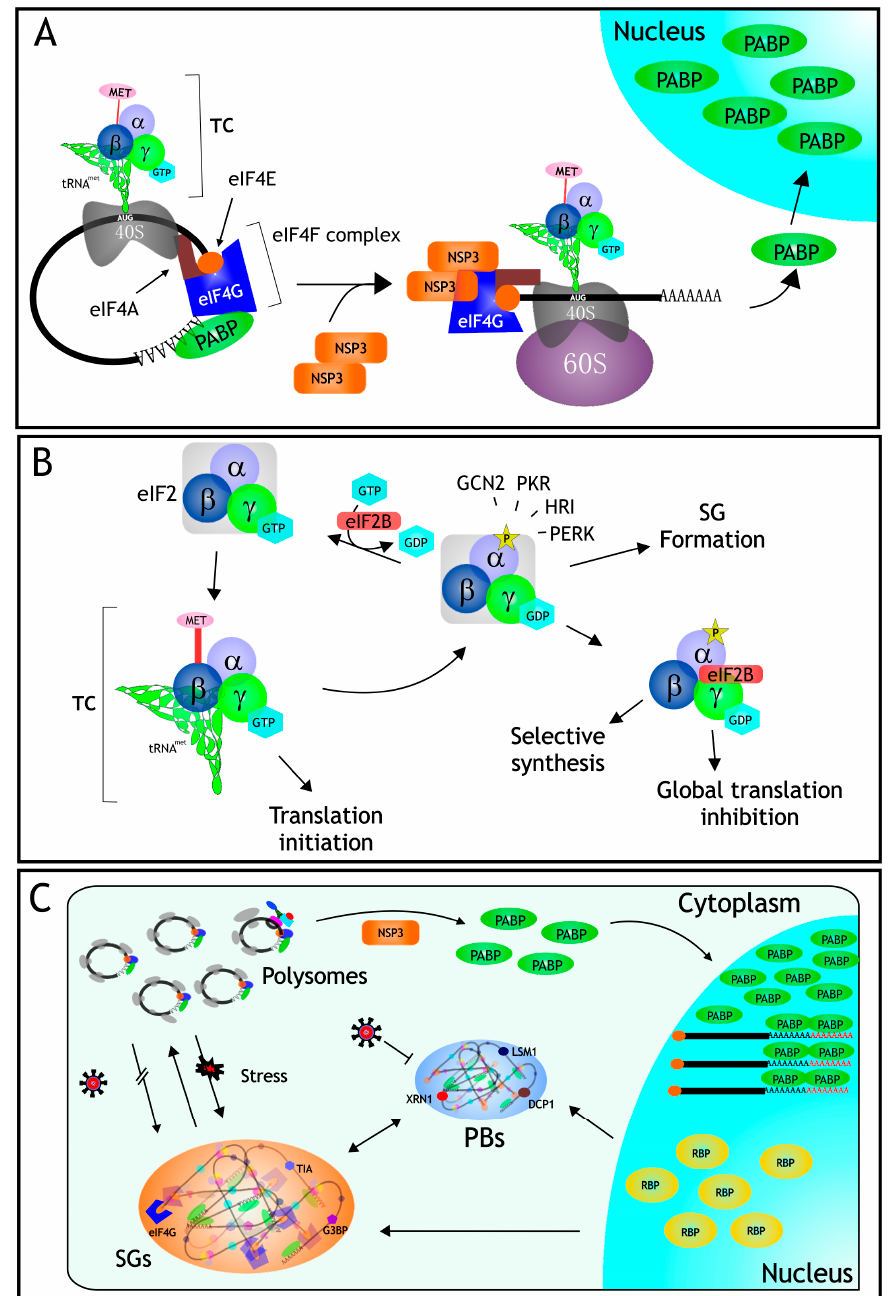
Figure 1. Translation control in rotavirus infected cells. ( A ) During the infection, the nonstructural protein NSP3 interferes with the translation machinery by displacing PABP from its site of binding in eIF4G, and also by indirectly causing the nuclear relocalization of PABP, and the accumulation and hyperadenylation of poly(A)-containing mRNAs (see text); ( B ) eIF2 is an heterotrimer formed by subunits ( α , β , and γ ); it binds to GTP and tRNA Met forming the ternary complex (TC) which is in charge of loading the initial Met residue during protein translation. During rotavirus infection, the α subunit of eIF2 becomes phosphorylated by PKR, preventing the formation of the TC, and thus causing a global translation inhibition; ( C ) Even under these severe inhibitory translation conditions caused by the infection, the formation of stress granules (SGs) is prevented, and the amount of processing bodies (PBs) decreases, despite the fact that several of the RBPs that assemble these RNA granules exit from the nucleus (see text for details).